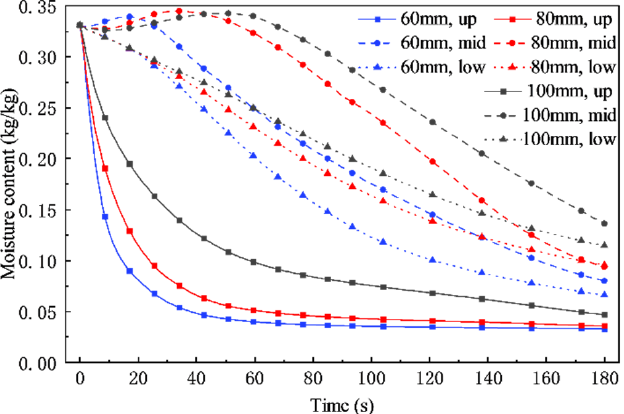
Figure 6. Average moisture content in different regions of the heaped tobacco strips models.